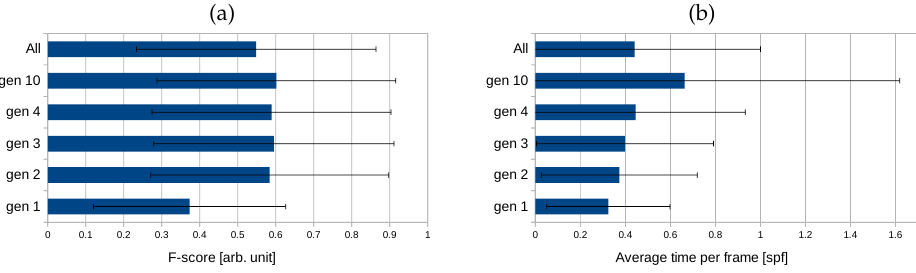
Figure 9. The effects of increasing the number of generations of HSA. ( a ) Comparison of F-score. ( b ) Comparison of average time per